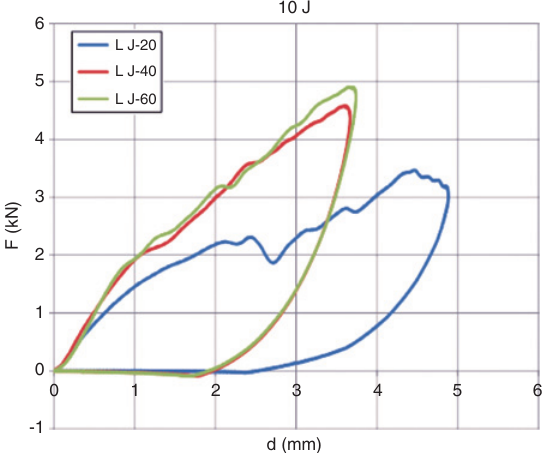
Figure 6 The contact load-deflection curves of composite single-lap joints.